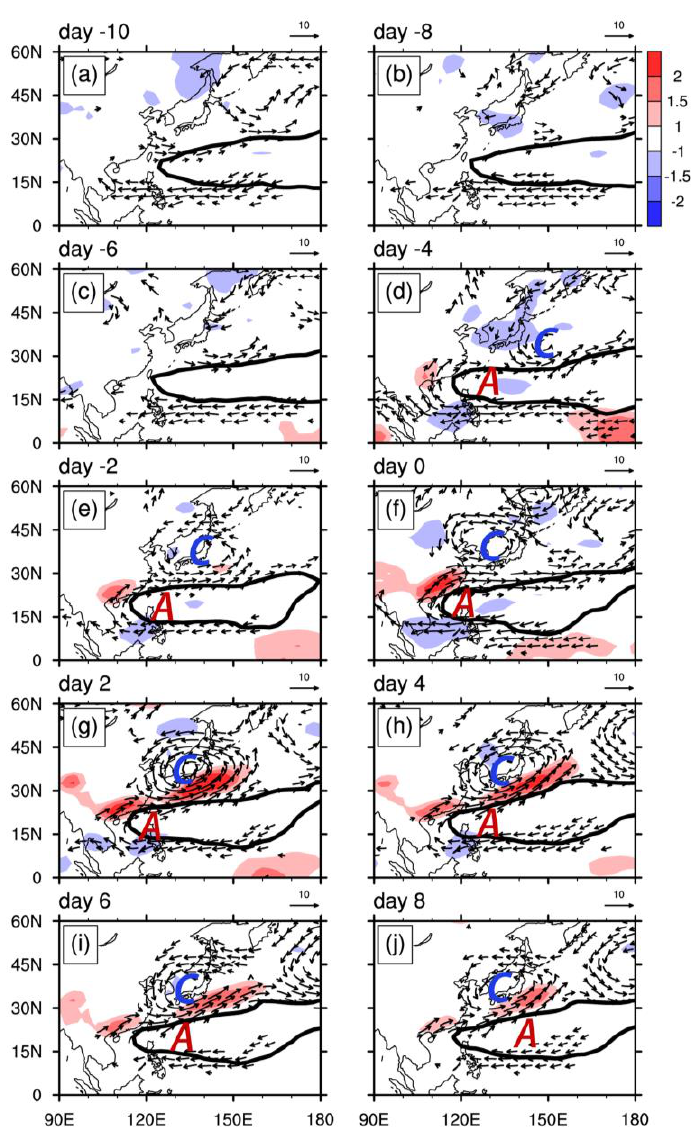
Figure 9. Composite 850 hPa horizontal wind anomalies (vector, units: m s −1 ) and normalized anomalies of total moisture flux (shading, with interval of 0.5 standard deviation) in EAP/SR-C events from day −10 to day 8 with interval of 2 days ( a – j ). The thick black lines (588 dagpm-contours) portray the activities of the WPSH at 500 hPa.